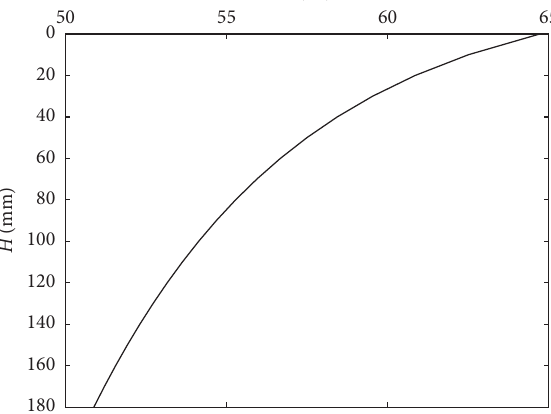
Figure 3: Temperature profile along the depth of pavement.